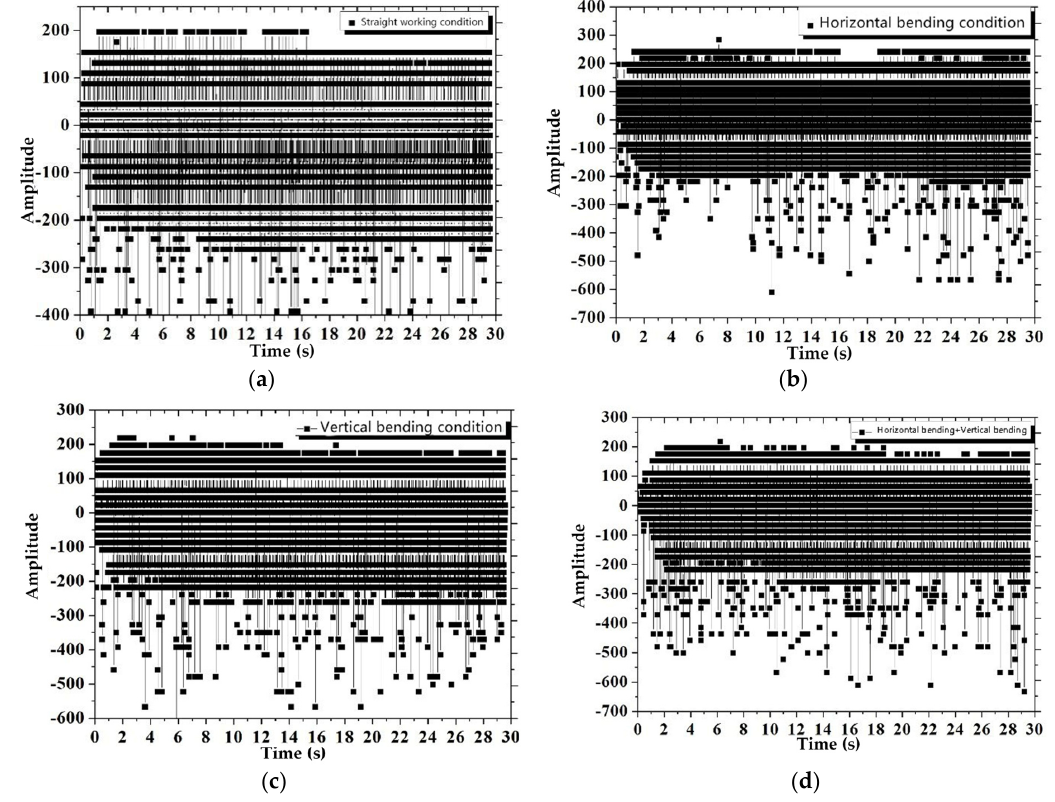
Figure 8. Vibration signals under four various terrain conditions. ( a ) Straight working condition. ( b ) Horizontal bending condition. ( c ) Vertical bending condition. ( d ) Combined working condition of horizontal and vertical bending.